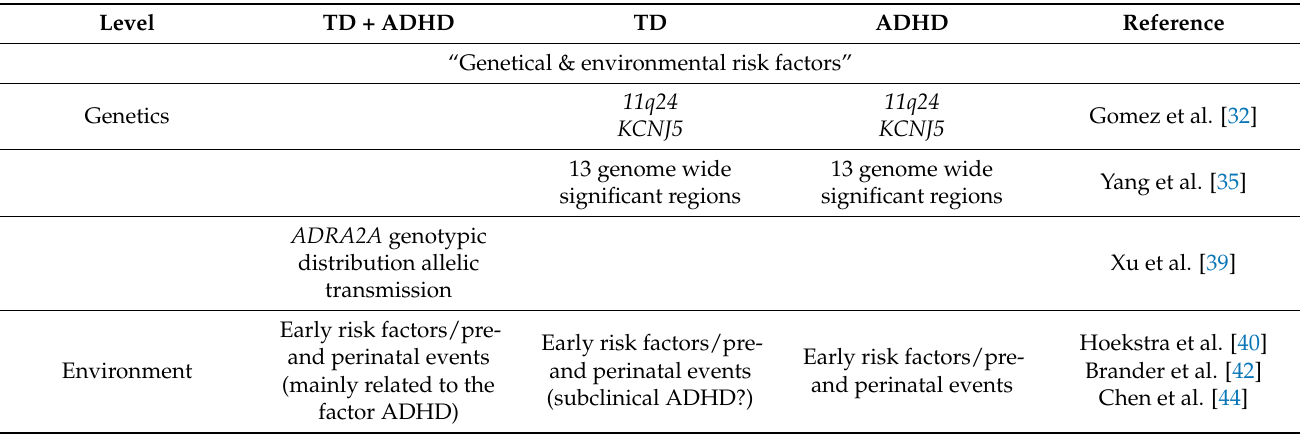
Table 1. Independence of deviations for biological parameters and environmental factors within